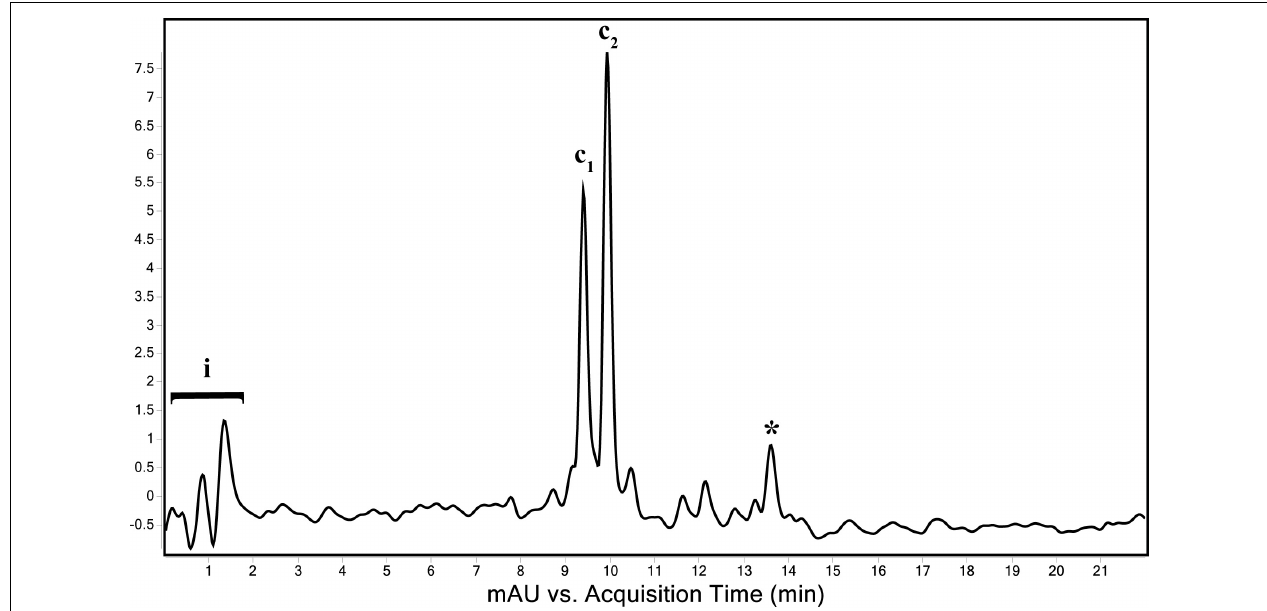
FIGURE 6 | Total wavelength chromatogram depicting the major pigments of “ Ca. C. masyuteum.” i—sample injection peaks; c 1 and c 2 —bacteriopheophytins corresponding to bacteriochlorophyll c ;